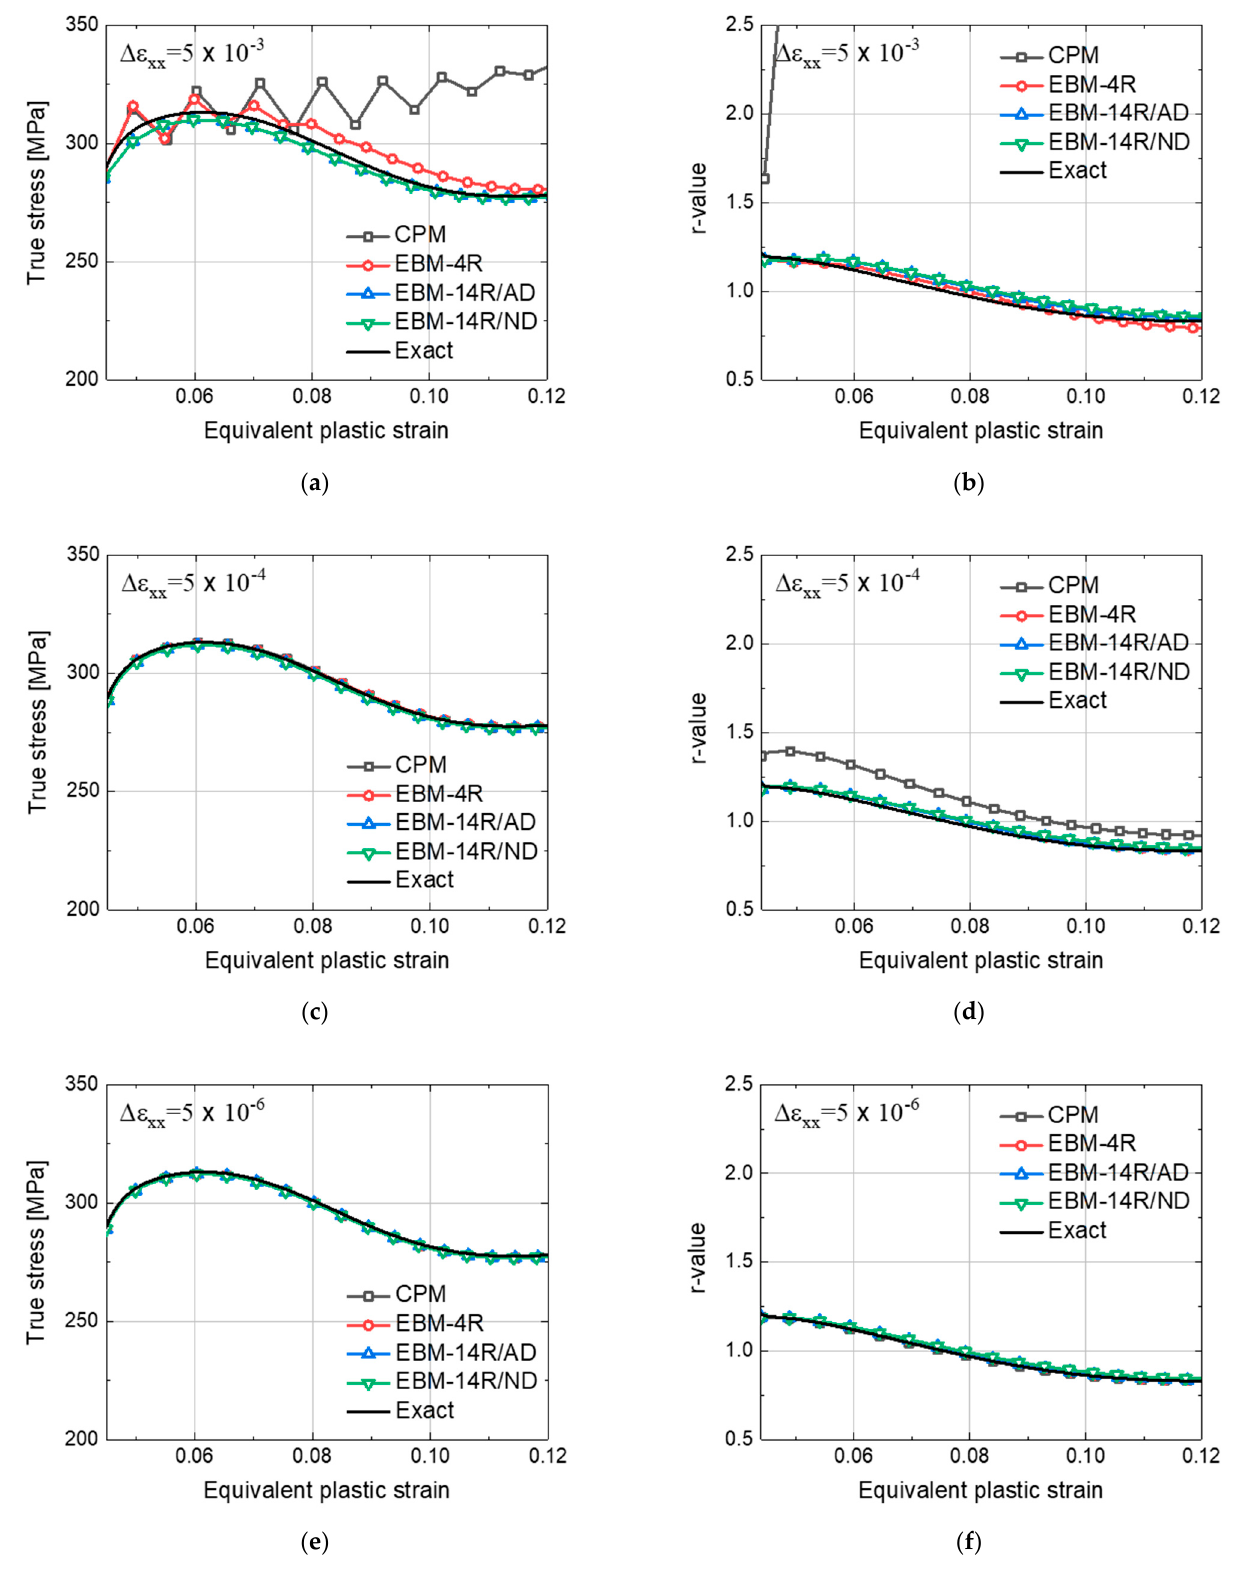
Figure 10. The evolution of the flow stresses and r-values of MAT 2 under C5T10CR path for different stress integration algorithms with strain increments: ( a , b ) ∆ ε xx = 5 × 10 − 3 , ( c , d ) ∆ ε xx = 5 × 10 − 4 and ( e , f ) ∆ ε xx = 5 × 10 − 6